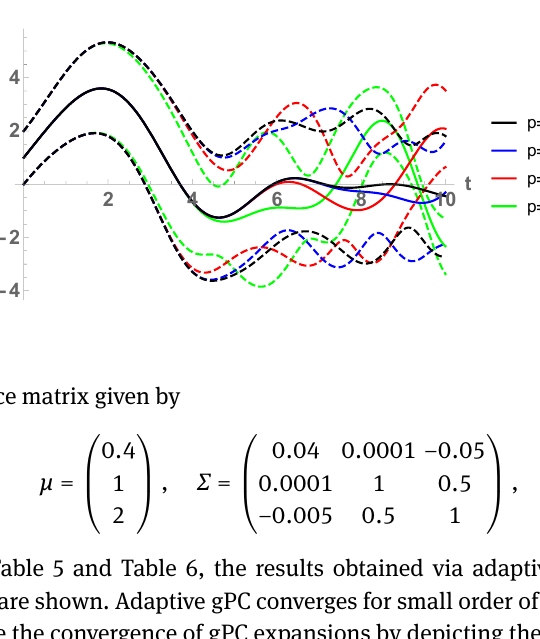
Figure 1: Expectation and confidence interval for the solution stochastic process, for orders of basis p = 1, 2, 3, 4 . Example 4.1, assuming independent random data.